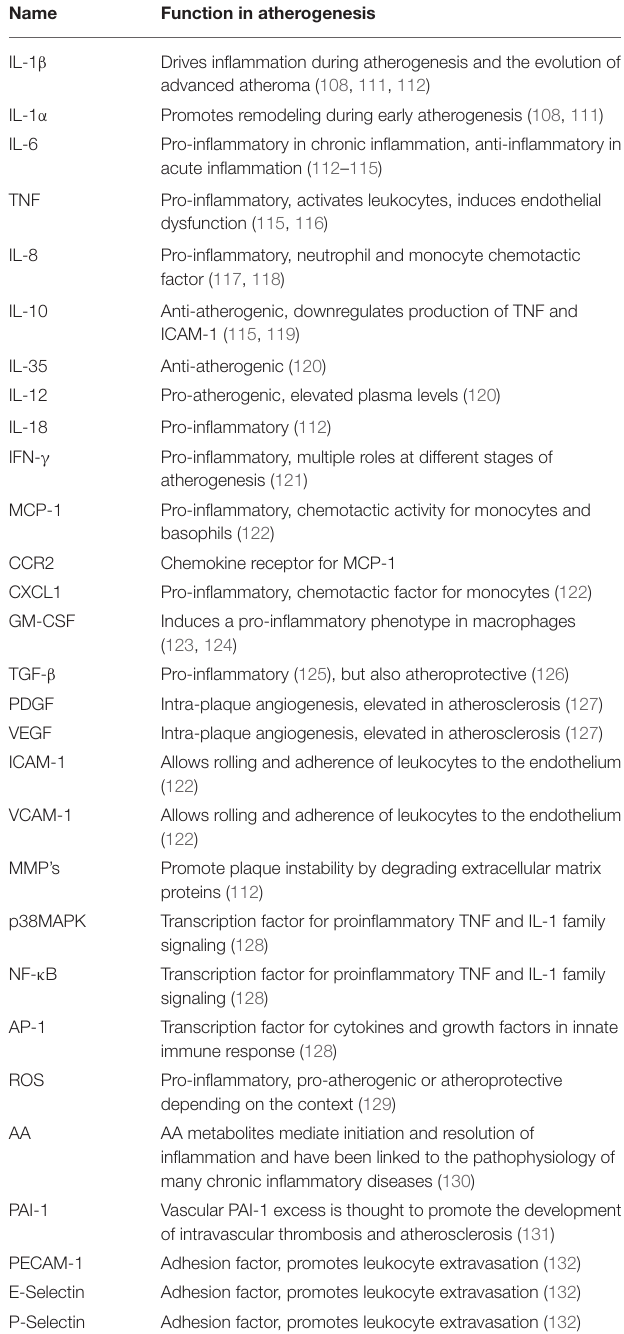
TABLE 1 | Main cellular mediators of